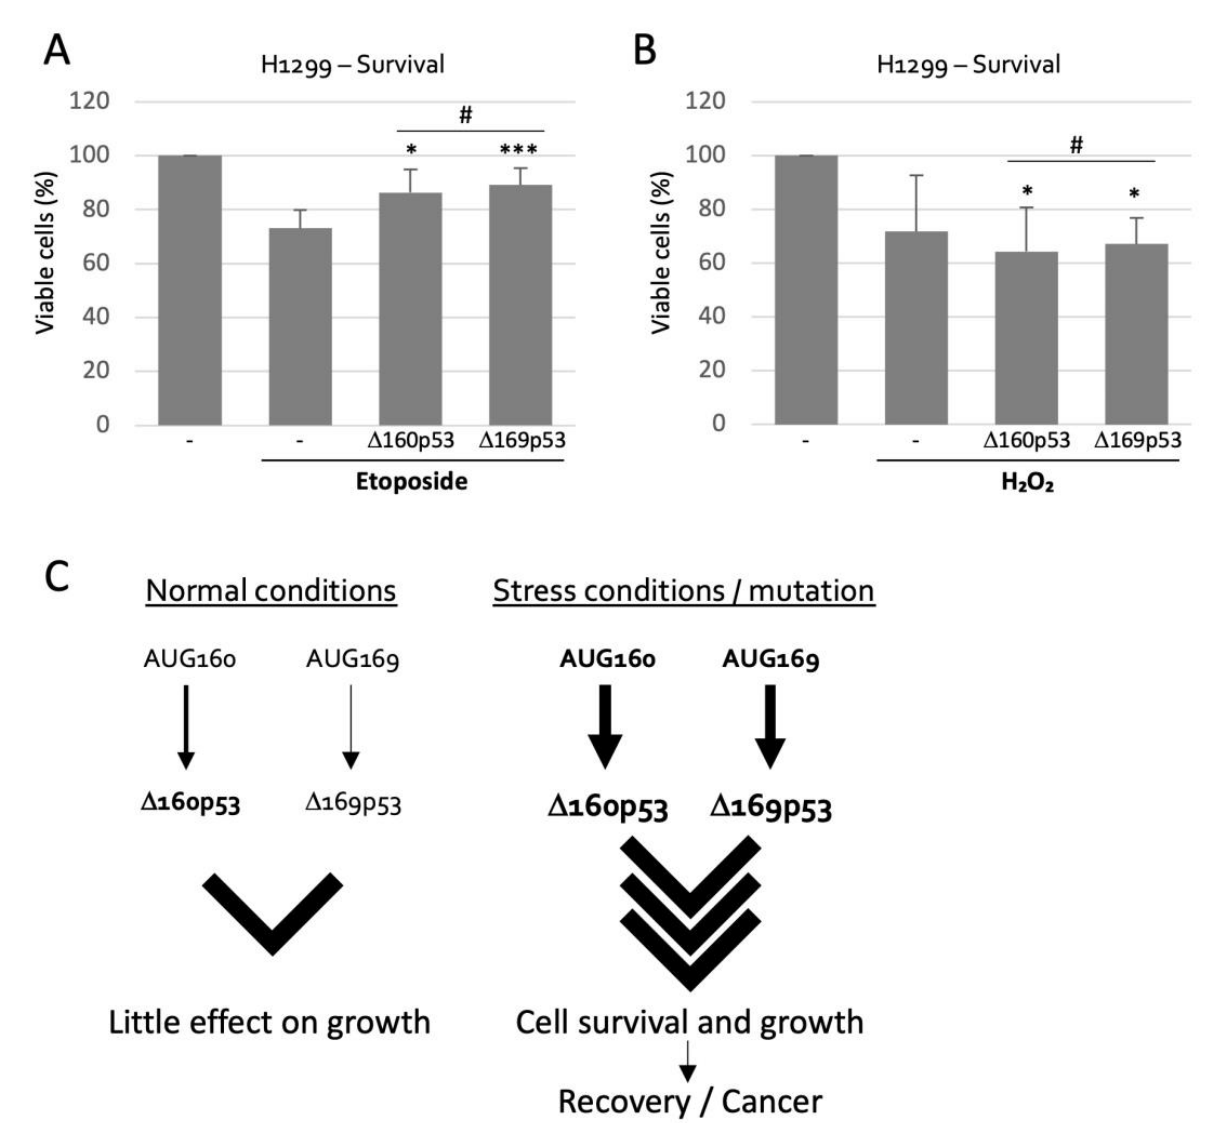
Figure 6. ∆ 160p53 and ∆ 169p53 proteins show identical functions: ( A,B ) MTT assay (proliferation/survival) of H1299 cells expressing or not ∆ 160p53 or ∆ 169p53 and treated or not with DNA damaging agent etoposide (21 h) ( A ) or hydrogen peroxide (H 2 O 2 , 24 h) ( B ), as indicated. Shown are averages ± s.d. of 2–4 experiments (# p > 0.05, * p < 0.05 and *** p < 0.005 compared to “Etoposide/ − (no p53 expression)” sample (A) or to “ − (no drug and no p53 expression)” (B) sample or as indicated). ( C ) Proposed model: Under normal cell growth conditions TIS160 and TIS169 show low activity and there is low expression of the corresponding protein isoforms, but under stress conditions or with mutation each of these individual TIS becomes more active and initiate translation of the two protein forms, ∆ 160p53 and ∆ 169p53, which have equal capacity to induce cell growth and survival, and which could lead to recovery from stress or, in the case of continued activation, cancer formation or cancer